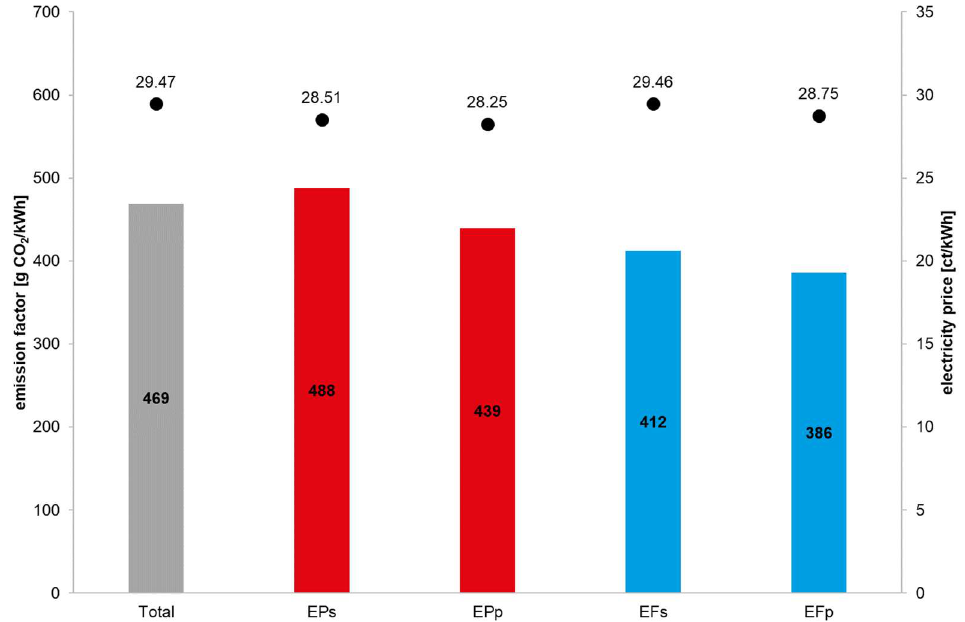
Figure 6. Annual CO 2 emissions (red EP and blue EF) and energy price (black dot) for all control strategies compared with average (grey) (own representation). strategies compared with average (grey) (own